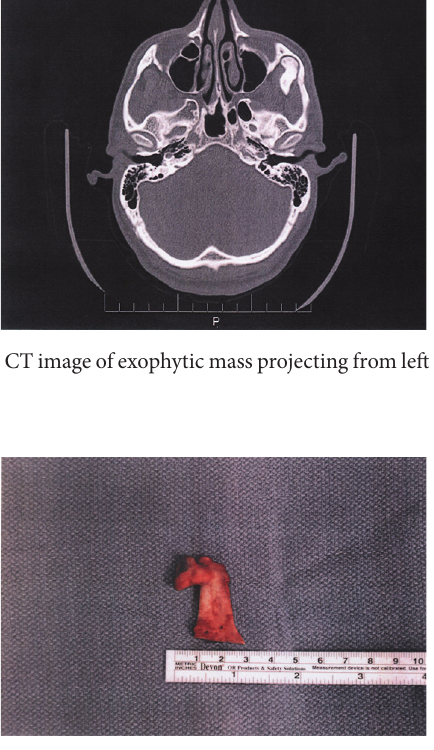
Figure 4: Resected osteochondroma and coronoid